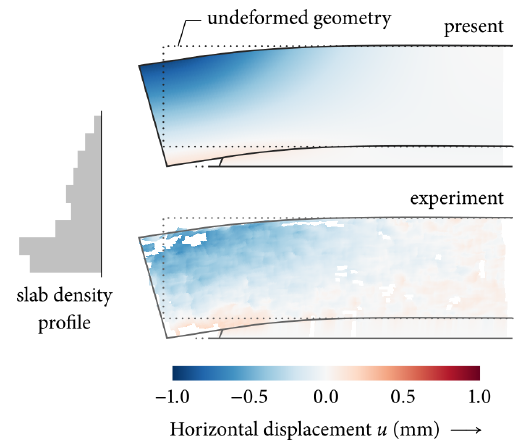
Figure 7. Horizontal displacement field of the first 1.3m of a flat- field propagation saw test (PST) with an a = 23cm cut into the t = 1cm weak layer under an h = 46cm slab. Comparison of the present model (top) with full-field digital image correlation mea- surements (bottom). White patches indicate missing data points. Deformations are scaled by a factor of 100 and the weak-layer thick- ness by a factor of 10 for